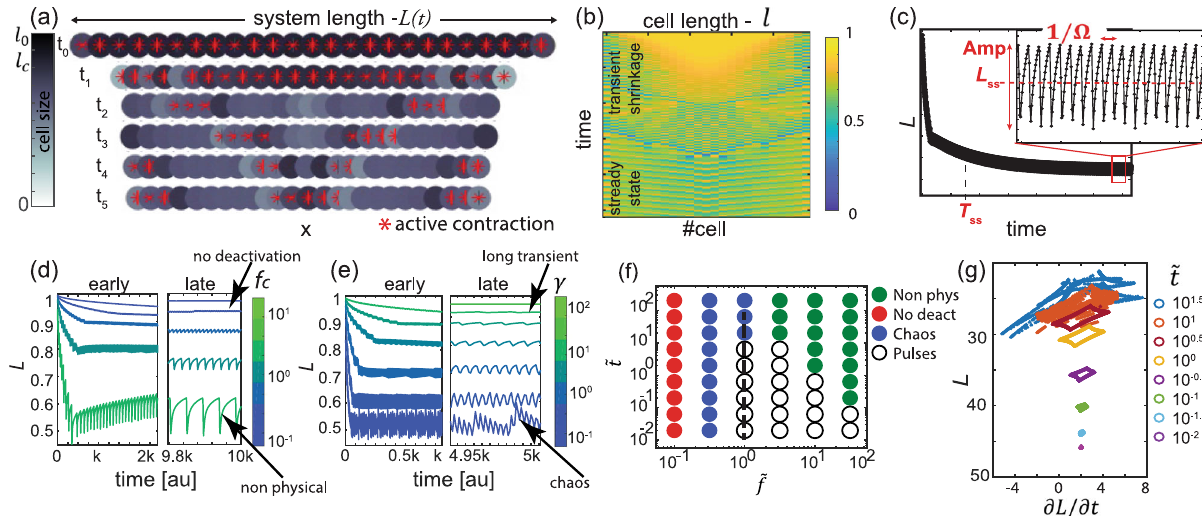
Fig. 3 Contraction pulses in a 1D oscillatory tissue. a Sequential snapshots from a dynamic simulation (Supplementary Movie 1) of a 1D chain of oscillatory cells (in which the critical cell length l c , is shorter than its rest length l 0 ). Cells are shown at their location along the chain, x , greyscale represents their length and red asters represent activated cells. At t 0 all cells are set to their elastic rest length l 0 . At t 1 the system is during its transient shrinking phase. At t 2 – 5 the system is at its dynamic steady-state: contraction pulses are constantly propagating from the edges to the bulk of the tissue, where they collide and annihilate. b A kymograph representation of the dynamics shows the transient shrinking phase, converging to the dynamic steady-state, where pulses propagate at constant speed from the rims to their annihilating point at the center. c A sample measurement of the entire system length L ( t ). During the transient shrinkage, a kink may be seen. Then, further exponential decay (with time scale we label T ss ) brings the system to its asymptotic average length L ss , around which it oscillates with frequency Ω and amplitude Amp . d – e Time series of L ( t ) as a function of the contraction force f c and the viscosity γ . We show early and late intervals, taken from long simulation runs. While we focus on ordered pulsatile behavior, different possible types of dynamics are seen at the extremities of parameter space. These include all-contractile (no-deactivation) mode; cell collapse to negative area (non-physical); increasingly long T ss (long transient); and irregular traveling pulses (chaos). More details in Supplementary Fig. 1. f A phase diagram shows the different types of dynamics as a function of the non-dimensional parameters e f (related to force) and ~ t (related to time). g A plot of the system length L vs. its variation in time ∂ L = ∂ t shows the sharp transition from an ordered pulsation mode (limit cycles) to chaos as a function of ~ t . The trajectory is depicted in a dashed line in ( f ). Plotted data points are taken from the